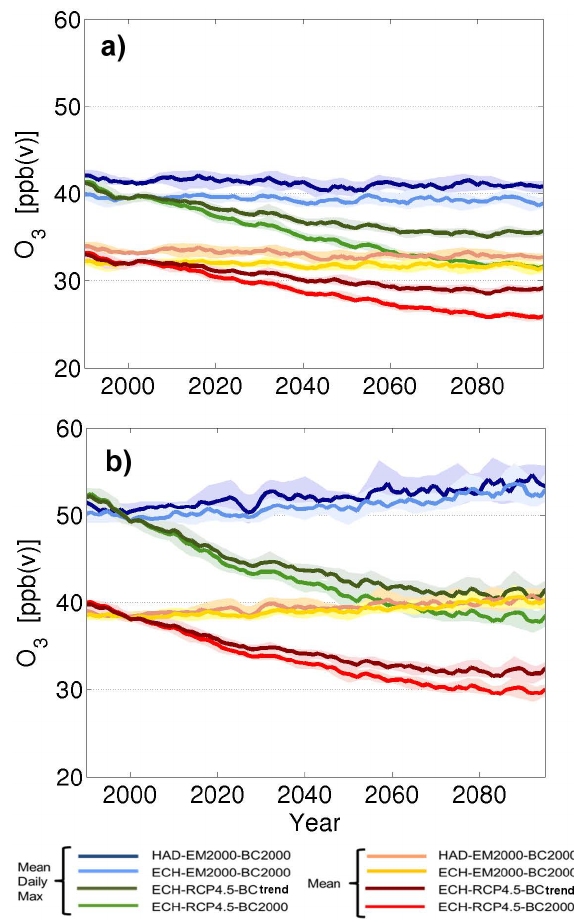
Fig. 1. Simulated geographical-average evolution of summer (April–September) mean surface O 3 concentration and summer mean of daily maximum surface O 3 concentration from 1990 to 2100. Results are (a) for the European land area north of 50 ◦ N and (b) south of 50 ◦ N. Thick lines correspond to a 5-yr running mean and the shaded areas correspond to the interval between the 5-yr running mean of the minimum and maximum summer mean